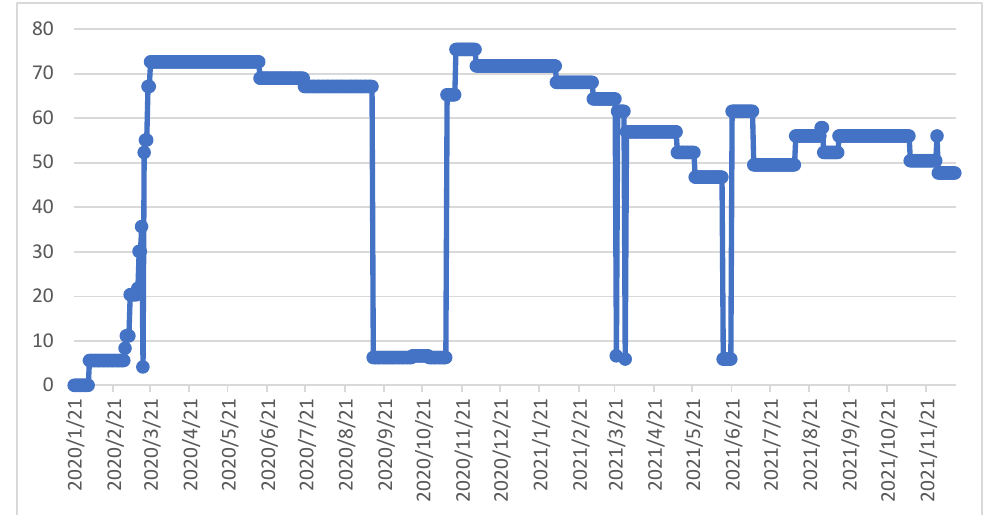
Figure 1. United States: Stringency Index (Source: Our World in Data). The average national Stringency Index masks important regional differences.